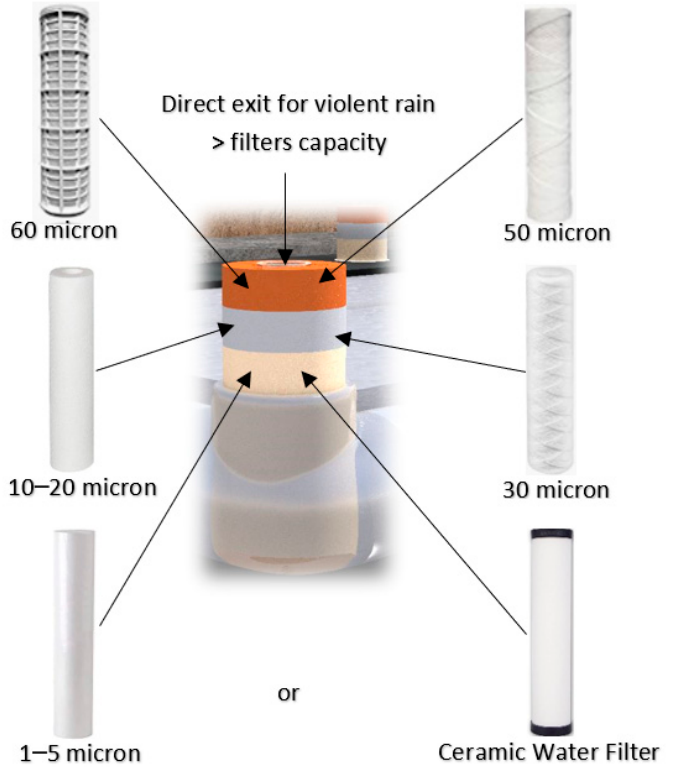
Figure 15. The schematic of the multilayer filter for drainage and sub-surface irrigation.